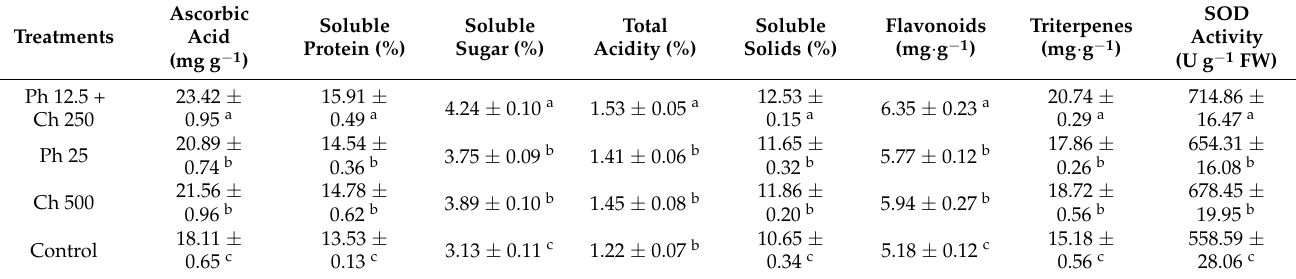
Figure 4. The impacts of physcion + chitosan, physcion, and chitosan on the weight ( A ) and yield ( B ) of fruits. The significant differences in the five treatments at 5% ( p < 0.05) level are stood by different letters. Error bar represents the SD of three duplicates. Table 3. The impacts of physcion + chitosan, physcion, and chitosan on fruit quality.